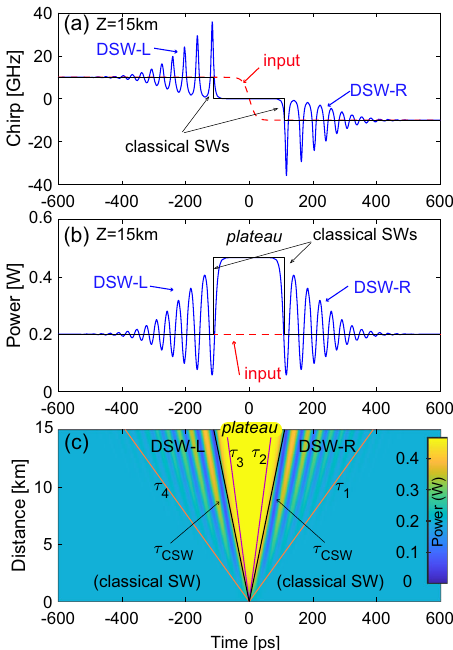
Fig. 2 Formation of two DSWs ruled by the full NLSE (with parameters of the experiment) contrasted with the CSWs of the dispersionless (isentropic gas-dynamic) case. Snapshot of chirp Δ f ( T , Z ) = u ( t , z )/(2 π T 0 ) ( a ) and power ∣ E ( Z , T ) ∣ 2 = ρ ( z , t ) P 0 ( b ) at the output Z = 15 km (blue solid line). The input (dashed red) is a frequency step Δ f ( z = 0) = ±10 GHz (see also Methods) on a constant power P 0 = 200 mW. c Evolution of power in T − Z plane showing the expansion fans of the two left (DSW-L) and right (DSW-R) shocks delimited by edge velocities in Eq. 6; The CSWs are the solid black lines in ( a , b ), while their velocities (Eq. 5) are given by the oblique black lines in ( c